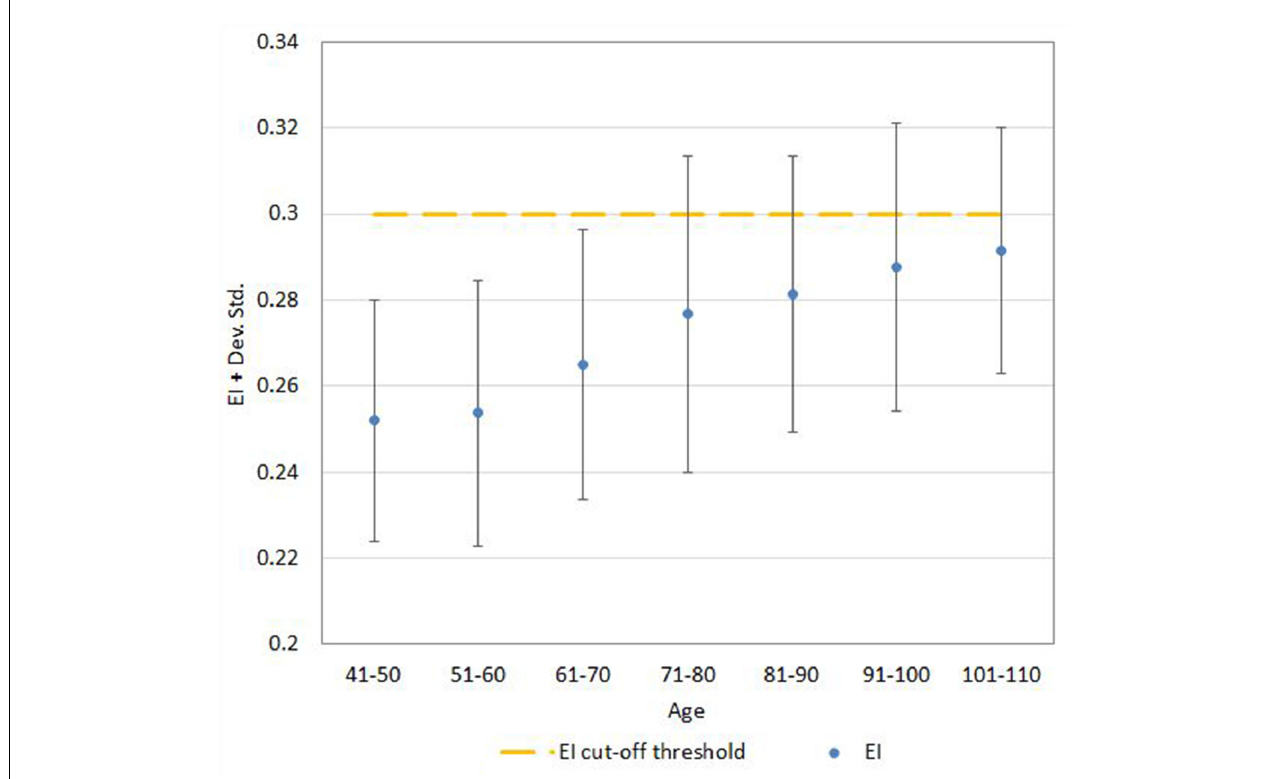
FIGURE 4 | Mean ± SD values for EI neuroimaging measure in each age (10-year) cohorts. Note: the upper part of the bar indicates the 97.5 percentile.